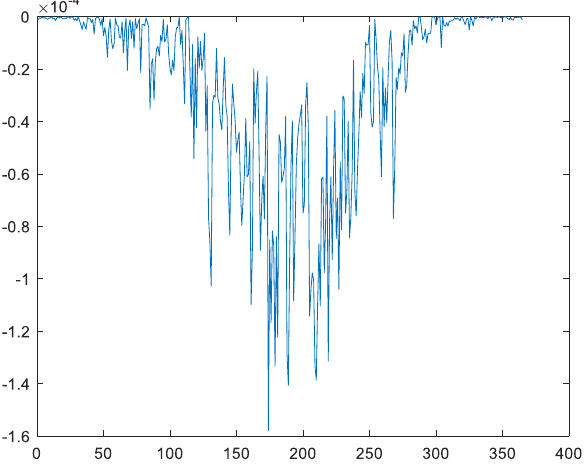
Figure 9. Offshore daily effect of environment on degradation trend over one year.